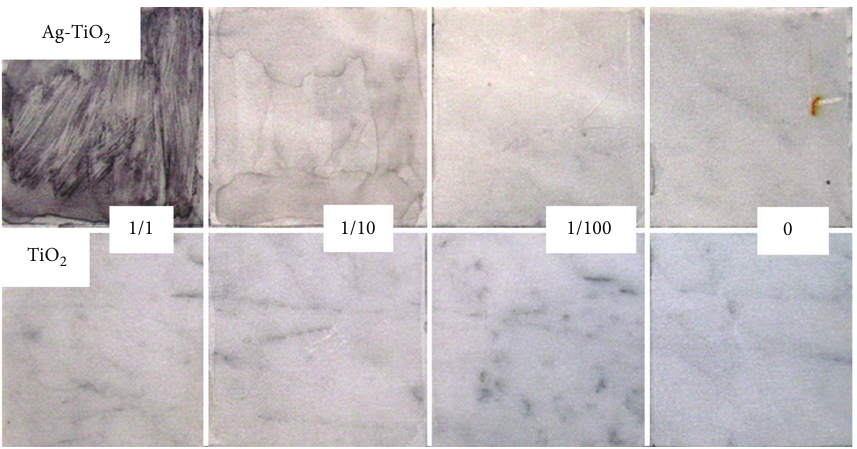
Figure 4: Treated samples with powder/binder mixtures at different ratios (1/1, 1/10, and 1/100).